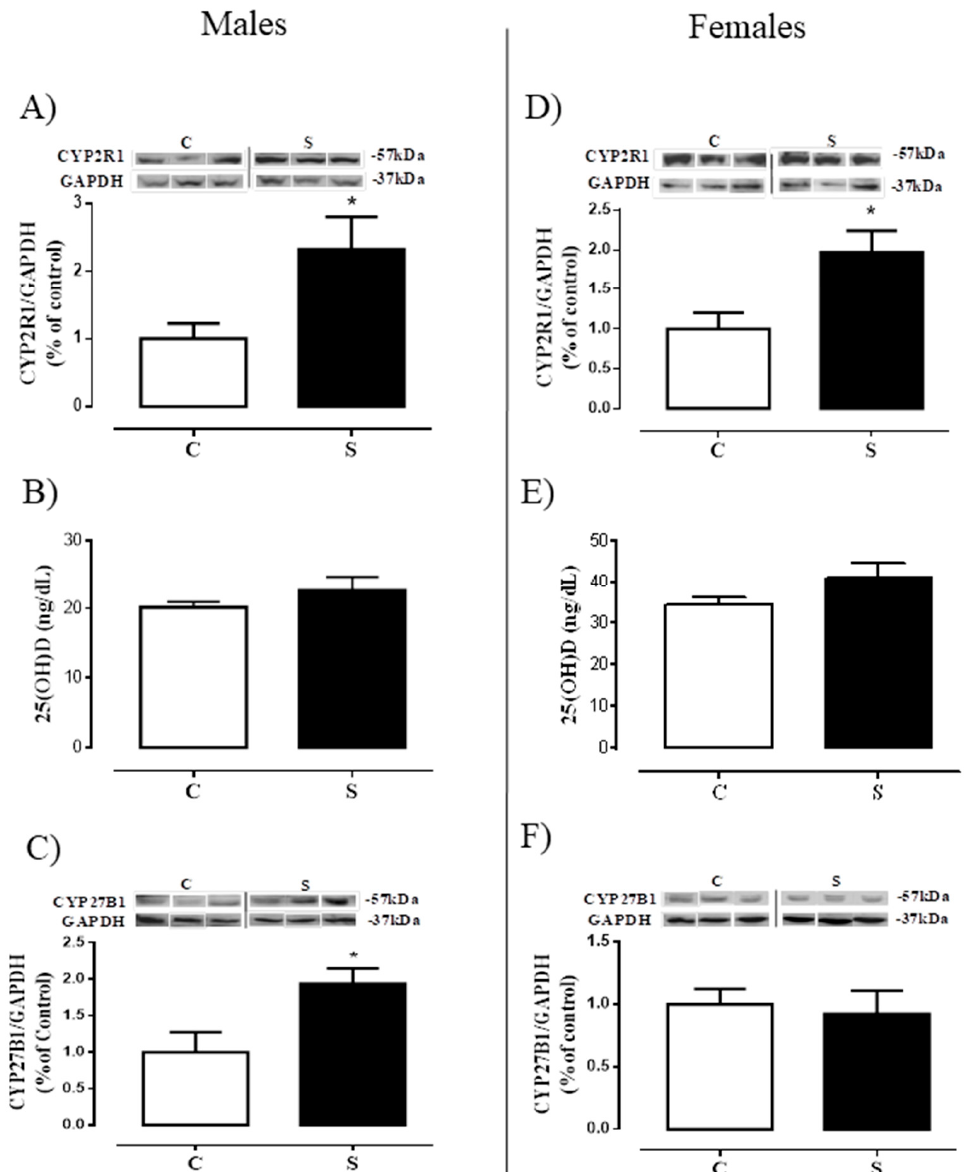
Figure 5. Vitamin D status of adult rats programmed by smoke exposure during the lactation period. Hepatic 25-hydroxylase (CYP2R1; A —male; D —female); Plasma 25-hydroxyvitamin D (25(OH)D) ( B —male; E —female); Visceral fat 1 α -hydroxylase (CYP27B1; C —male; F —female). Groups: C—CONTROL and S—SMOKE. Values are given as means ± S.E.M. of 5–10 rats/group. * p < 0.05 significant difference between S vs. C.